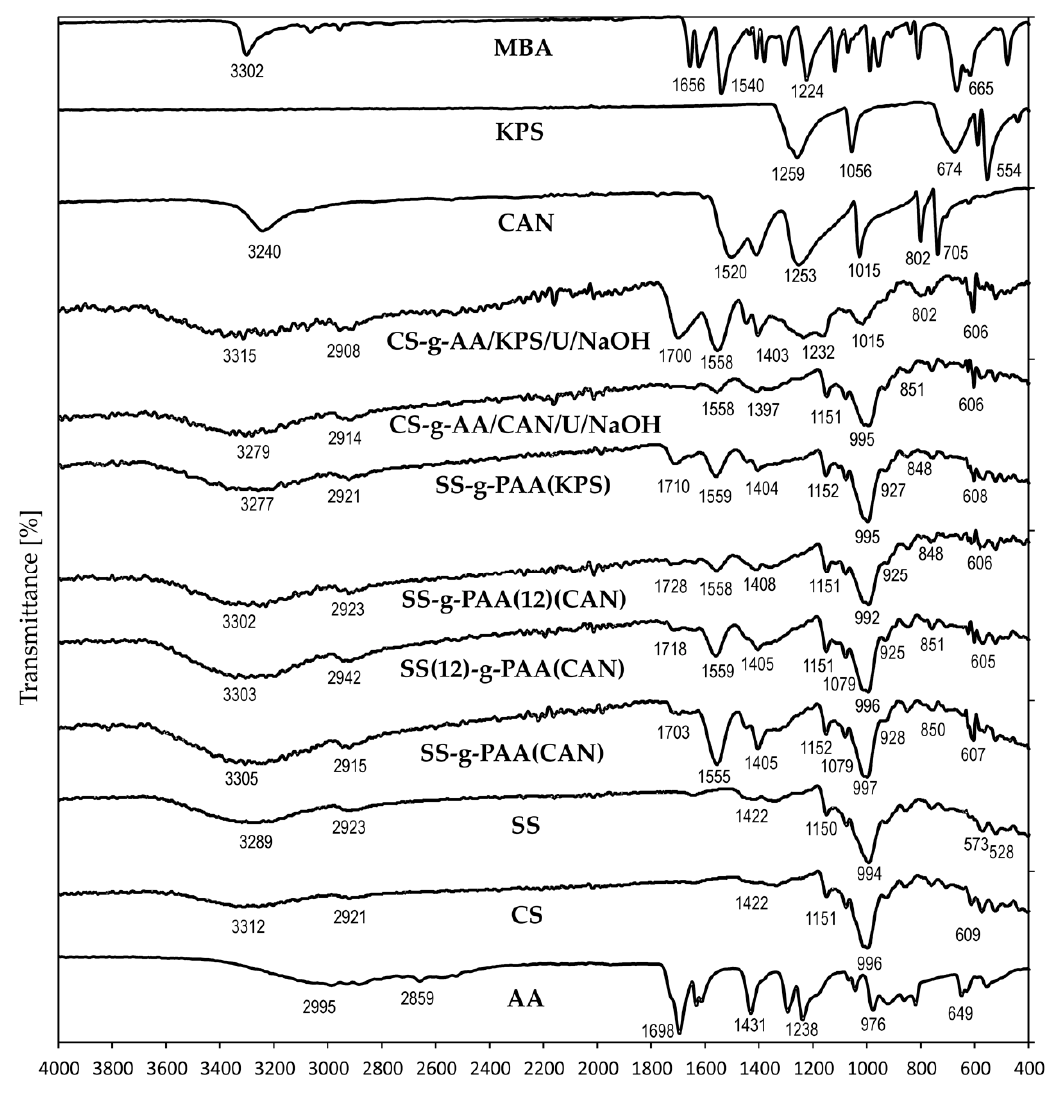
Figure 3. FTIR spectra of SS, SS-g-PAA (12)(CAN), SS(12)-g-PAA (CAN), SS-g-PAA (CAN), SS-g-PAA (KPS), CS, CS-g-PAA (KPS), CS-g-PAA (U/NaOH/CAN), AA and MBA.